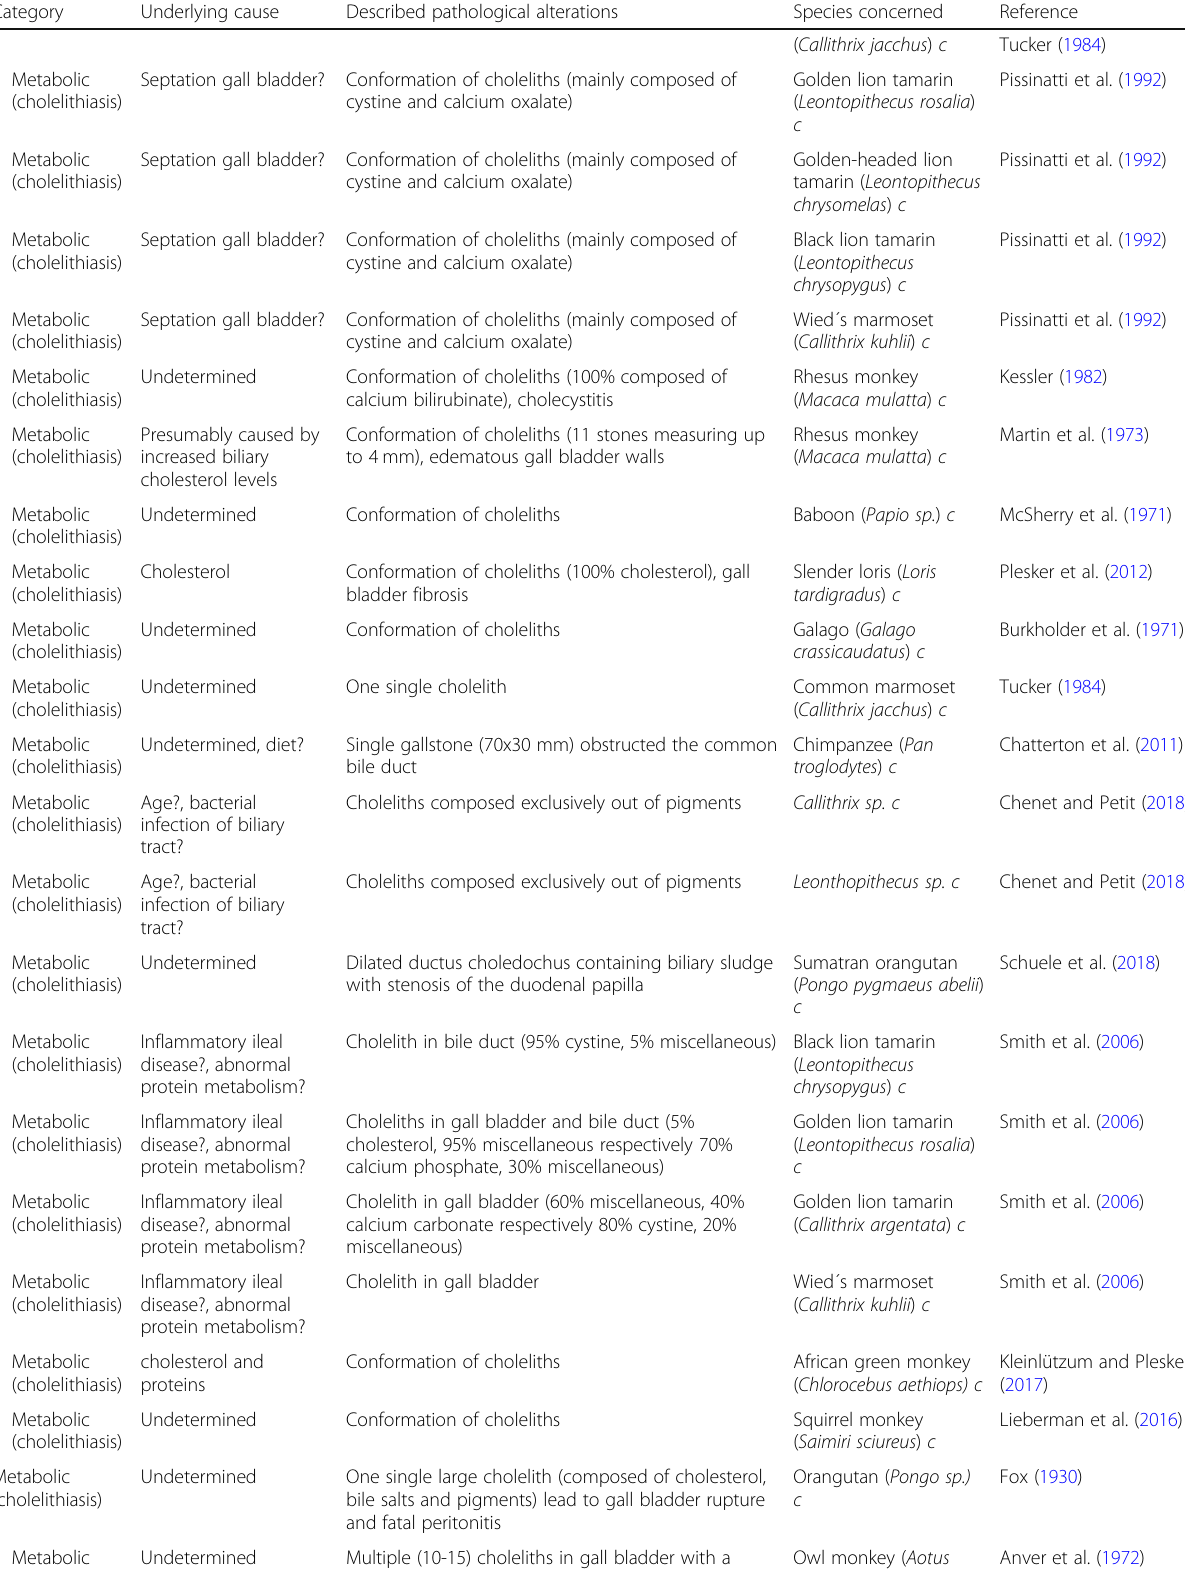
Table 1 Reported pathologies of the extrahepatic biliary tract in mammalian exotic pets and wildlife species (Continued)